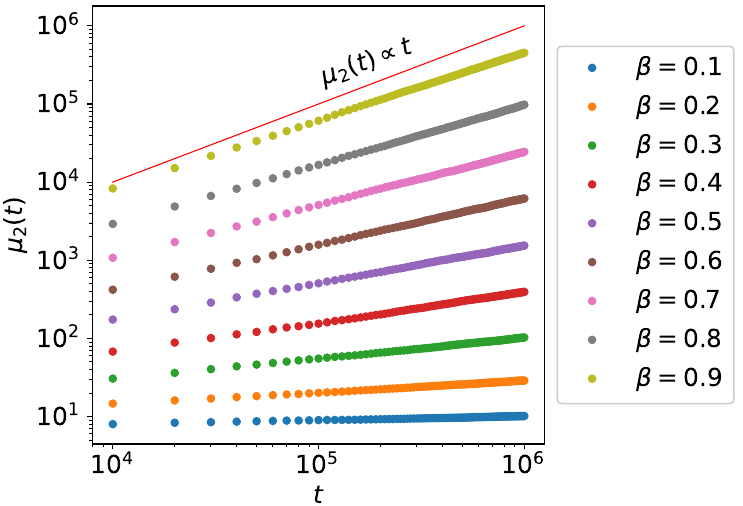
Figure 2. Plots of second moments for Monte Carlo simulated trajectories. Each value of β has N = 10 4 trajectories. The parameters used were α 0 = 0.6, ν = 1, λ = 1 and τ 0 =